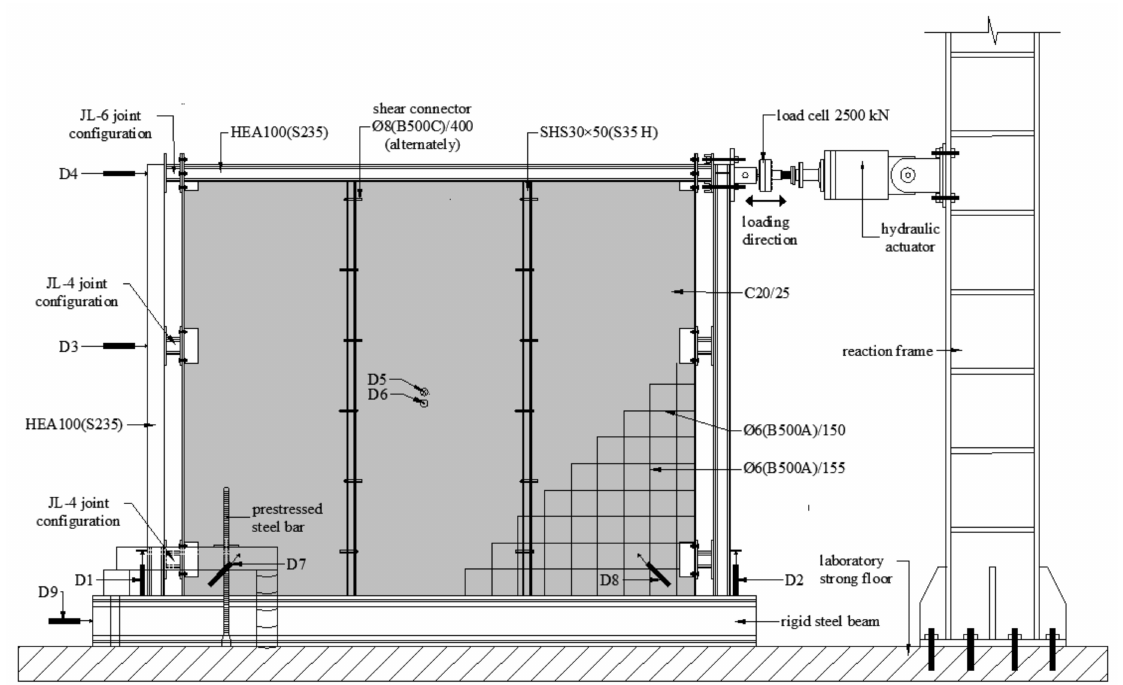
Figure 22. Experimental setup of the PCSP-ISF model and instrumentation of the in-plane cyclic loading